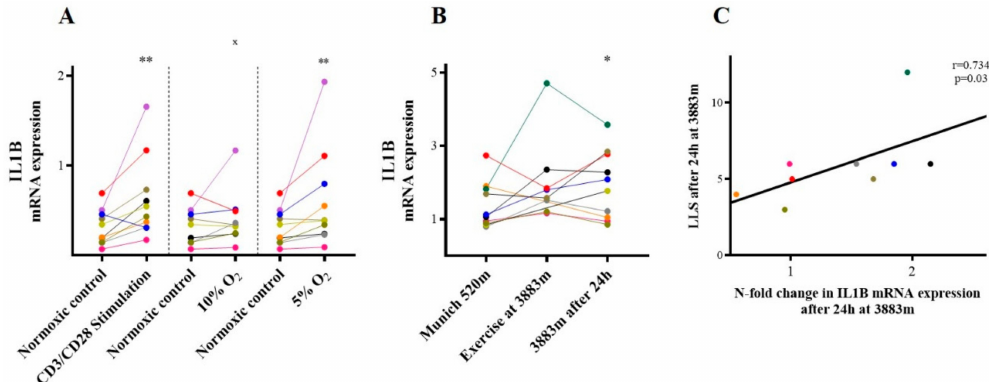
Figure 2. IL-1 β . IL-1 β mRNA expression ( A ) in vitro following inflammatory and hypoxic incubation, and ( B ) in vivo at di ff erent timepoints. ( C ) Association between LLS and IL-1 β mRNA expression (n-fold change) at 3883 m a.s.l. after 24 h. * p ≤ 0.05 and ** p < 0.01 vs. baseline (Munich 520 m or normoxic control in vitro), x p ≤ 0.05 vs. CD3 / CD28-stimulation, p ≤ 0.05 vs. prior time point in vivo (n.s.). IL-1 β = Interleukin 1 β . LLS = Lake Louise Score.